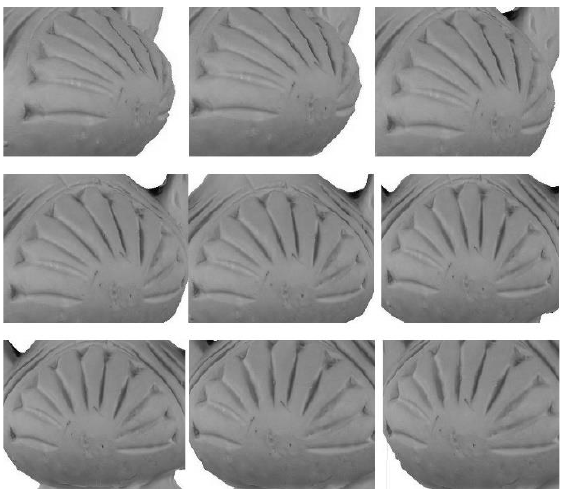
Figure 8. Images of the cut fragment from the object model. Figure 10 (f) shows the plotted graphs of two surface profiles with similar structures.